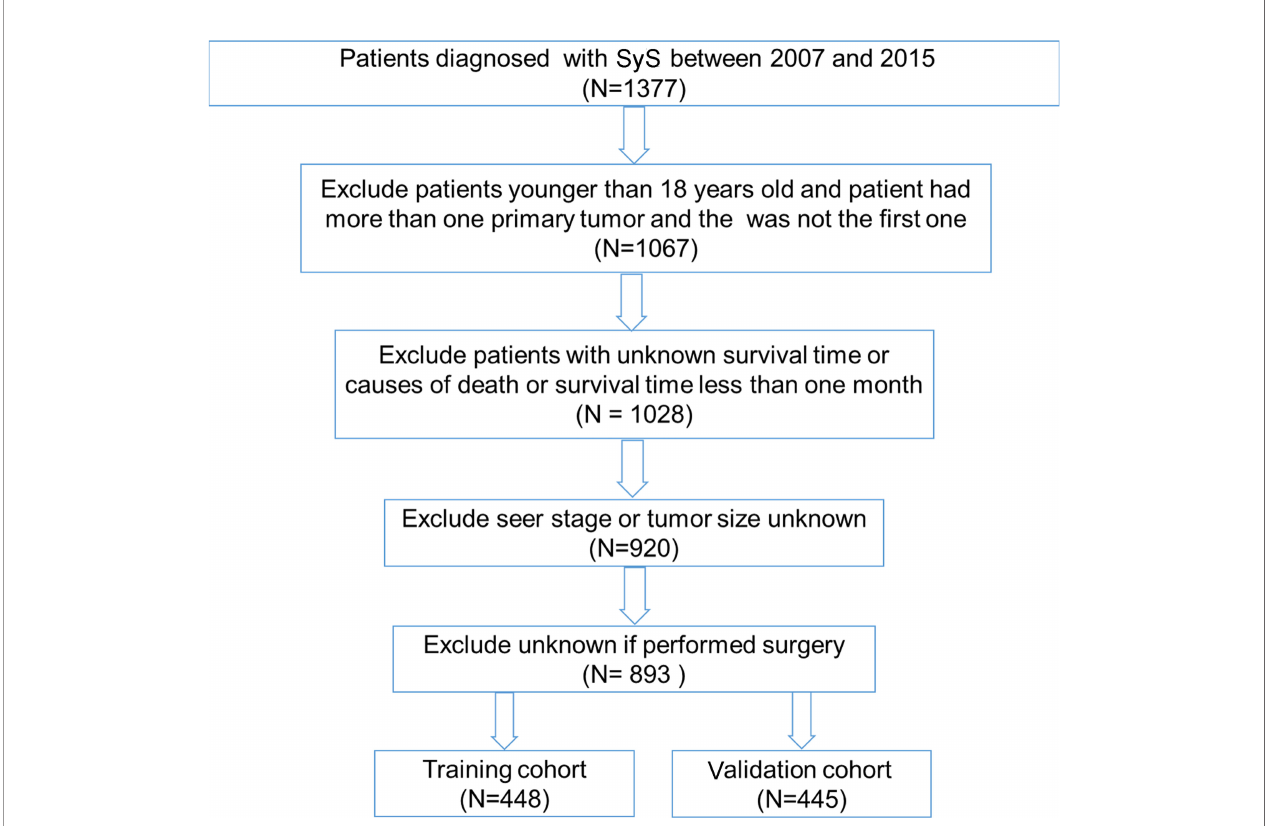
FIGURE 1 | Flowchart of the synovial sarcoma (SyS) patient selection process in our